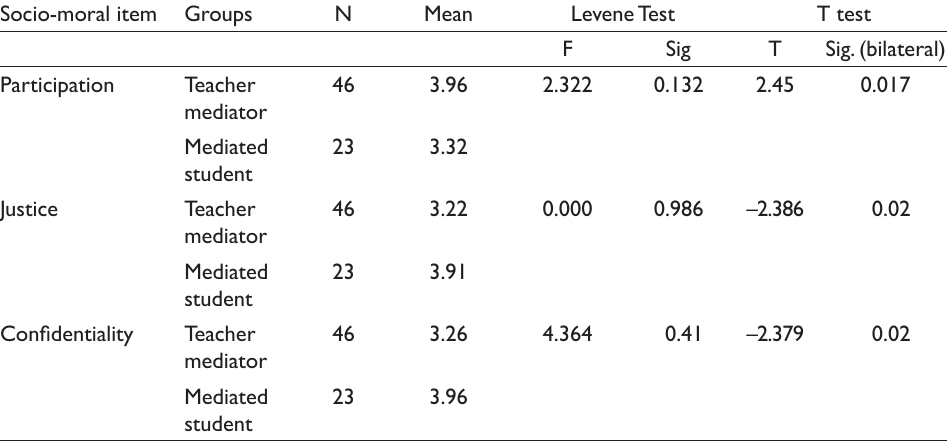
Table 8: Significant differences in the socio-moral items between teacher mediator and mediated